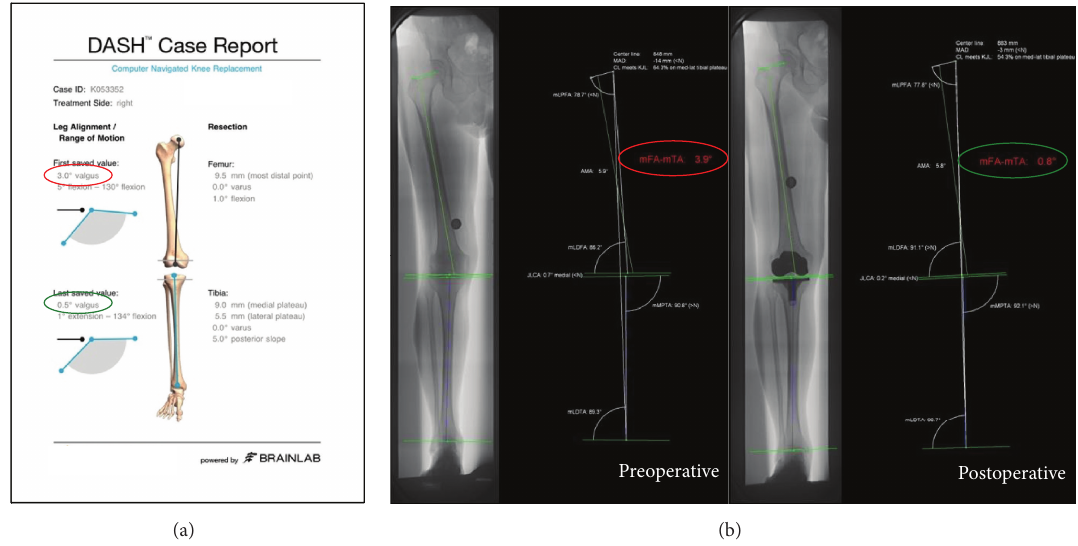
Figure 3: (a) Patient report generated by the navigation system after surgery. (b) Pre- and postoperative full-length weight-bearing radiographs. Axial limb alignment was measured using the planning tool